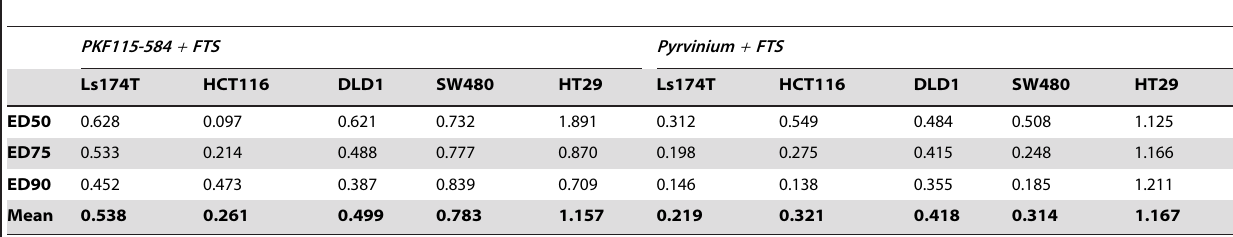
Table 1. Combination Index values obtained at ED50, ED75 and ED90. The average of the three values is reported in the last row.